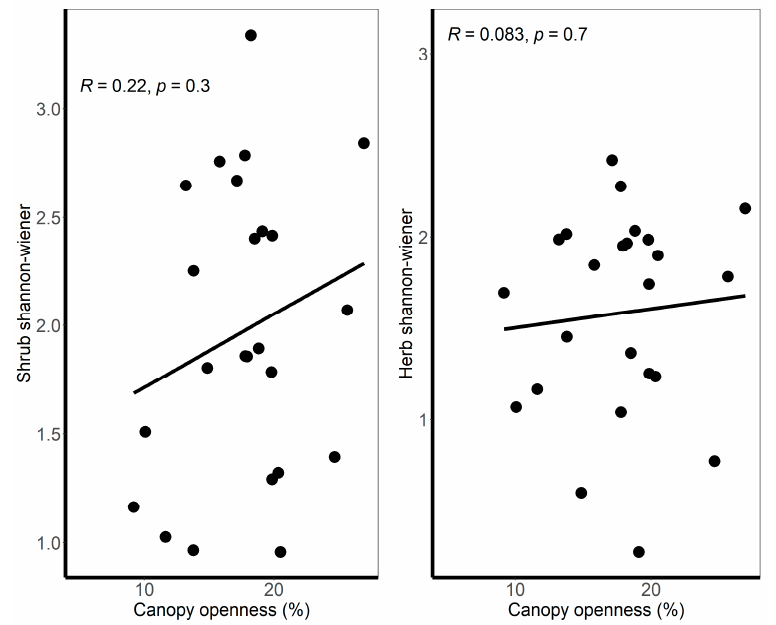
Figure 7. The relationship between canopy openness and shrub diversity, and herb diversity.